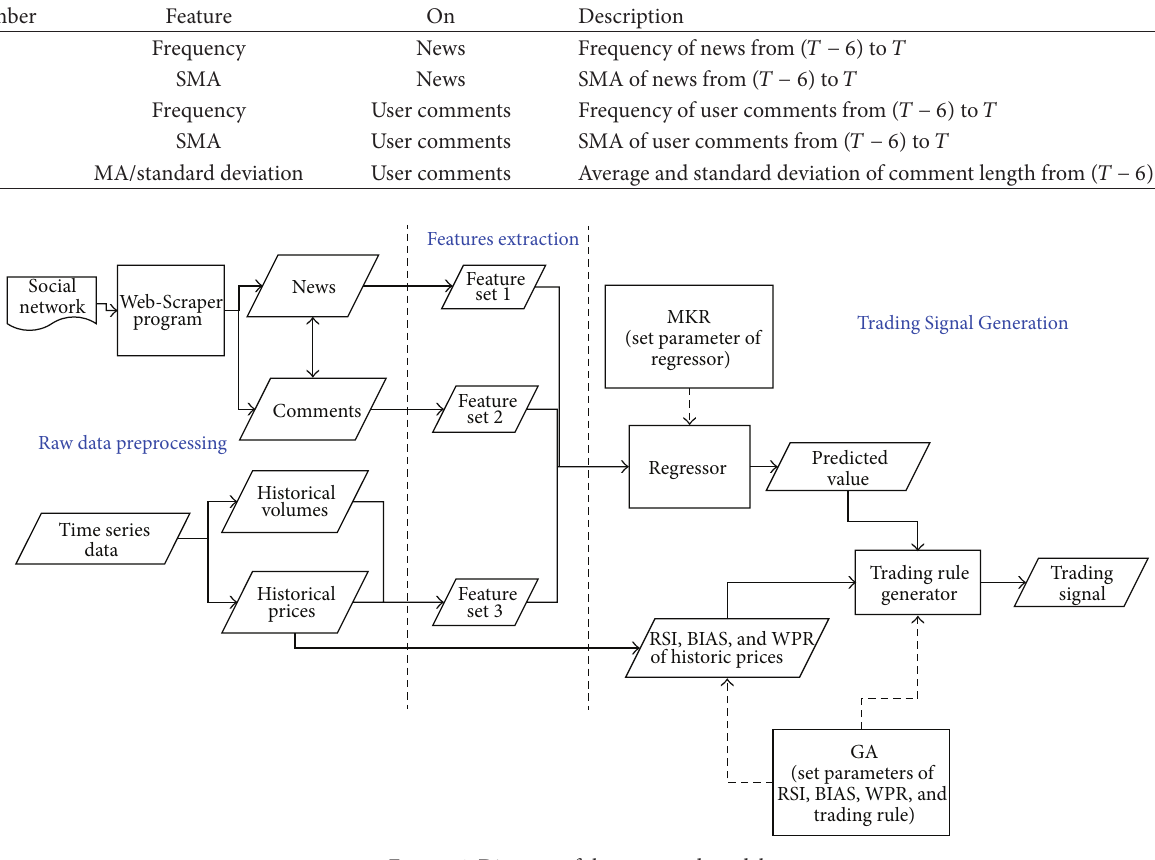
Figure 1: Diagram of the proposed model.